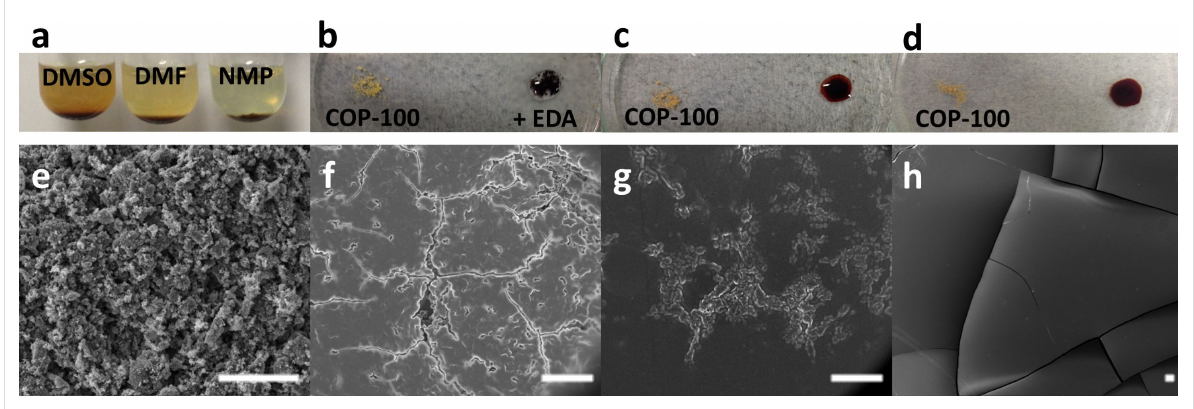
Figure 2: (a) Low solubility of COP-100 in polar aprotic solvents. (b) Instant color change of COP-100 by the addition of EDA dropwise at r.t., (c) dissolution of COP-100 in EDA at 100 °C in a few seconds, and (d) formation of COP-100 film at 100 °C in a few minutes (less than 5 min). SEM image of (e) pristine COP-100 powder, and EDA-treated COP-100 at 100 °C for (f) 1 min, (g) 3 min, and (h) 5 min (scale bar = 10 μ m).